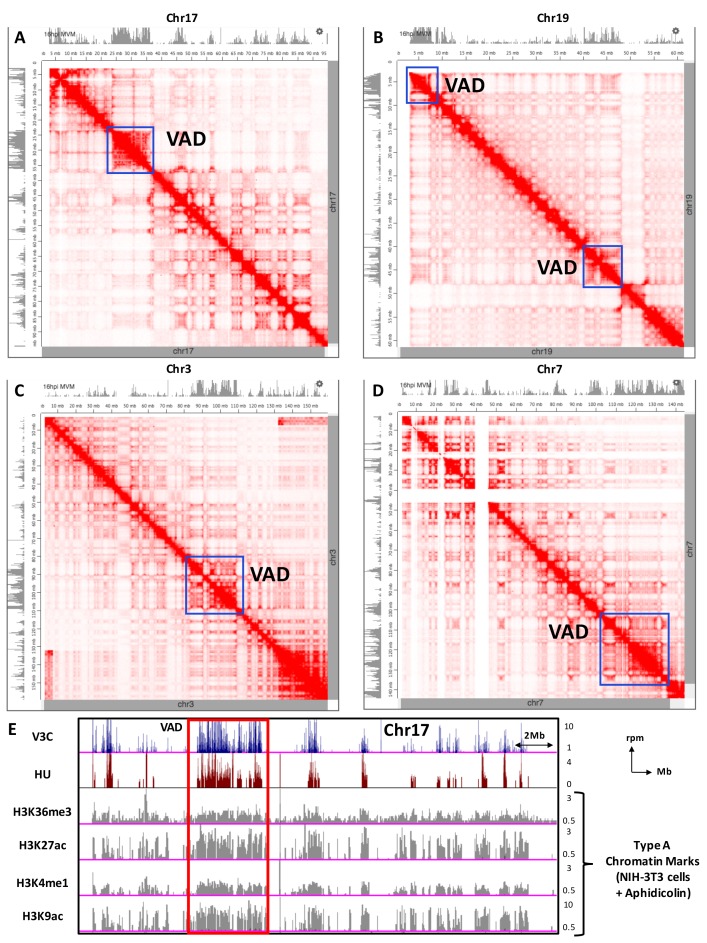
Comparisons of MVM-associated VAD sites with topological structure of the mouse nucleome.Hi-C contact maps in murine CH12 cells were visualized in comparison with MVM-V3C in A9 cells at 16 hpi (grey tracks on top) using the Juicebox data visualization platform (presented as red heatmaps, [Durand et al., 2016; Rao et al., 2014]). Representative contact maps are shown for Chromosomes: (A) 17, (B) 19, (C) 3 and (D) 7. Blue squares indicate robust VAD regions that coincide with Hi-C contact domains. (E) MVM interaction sites on the mouse genome identified by V3Cseq at 16 hpi was also overlayed with published chromatin marks (Kraushaar et al., 2013) for Type A chromatin (Rao et al., 2014) including tri-methylated histone H3 at lysine 36 (H3K36me3), acetylated histone H3 at lysine 27 (H3K27ac), mono-methylated histone H3 at lysine 4 (H3K4me1) and acetylated histone H3 at lysine 9 (H3K9ac) in Aphidicolin-induced NIH-3T3 cells (Kraushaar et al., 2013). Reads-per- million (rpm) values of the ChIP-seq pulldowns are indicated to the right of each corresponding histogram track.